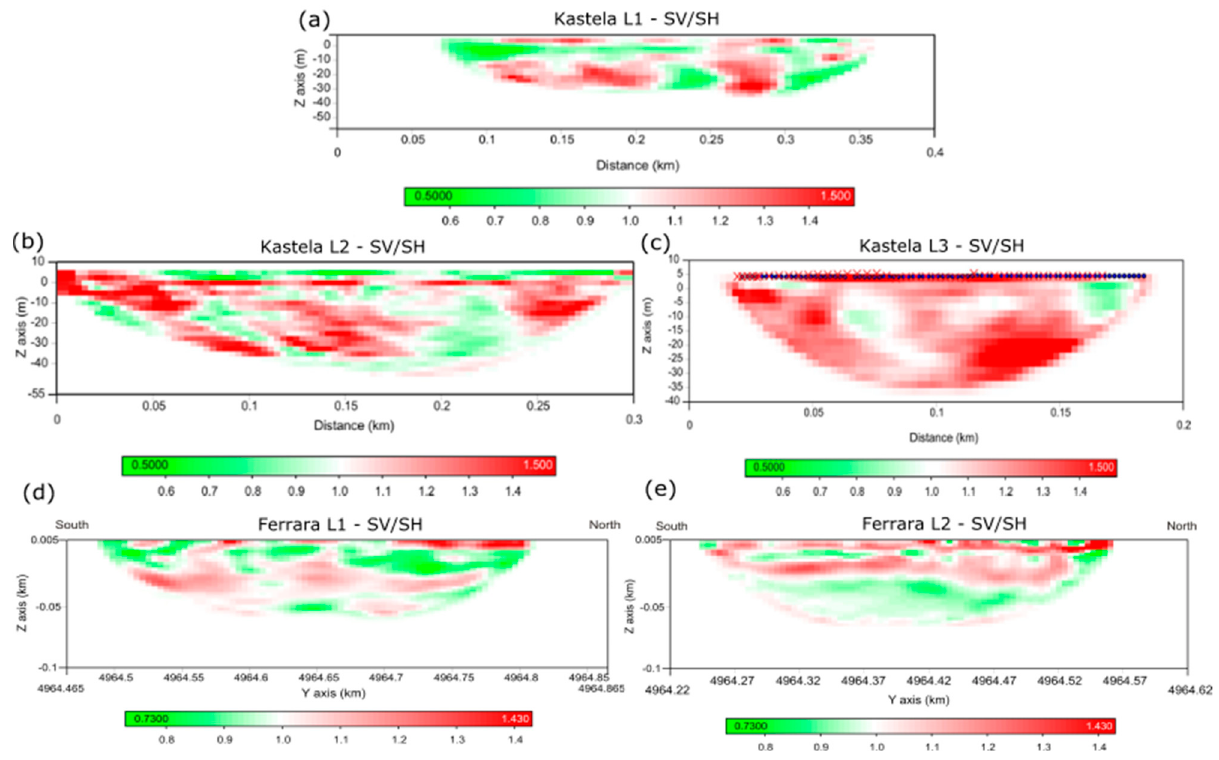
Figure 7. V SV /V SH ( a ) Kaštela Line 1. ( b ) Kaštela Line 2. ( c ) Kaštela Line 3. ( d ) Ferrara Line 1. ( e ) Ferrara Line 2.